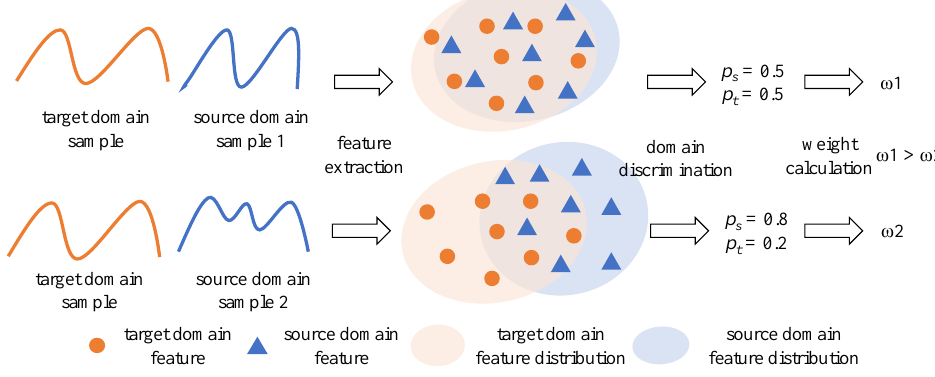
Figure 2. Transferability quantification